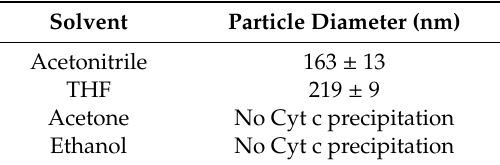
Table 2. Di ff erent anti-solvents used to nanoprecipitate Cyt c a .